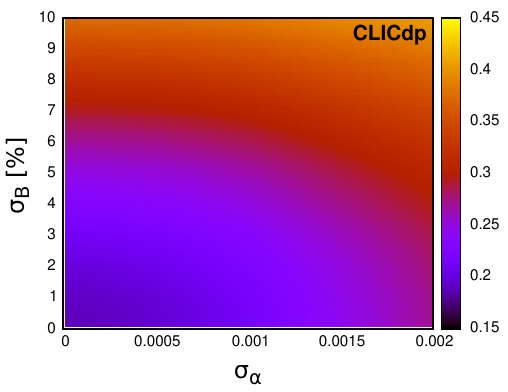
Figure 9 . Expected statistical uncertainty on the top Yukawa coupling from the fit involving all considered model parameters (5D), as a function of the strong coupling constant and background contribution uncertainties. Normalisation uncertainty, ∆ = 1% , is